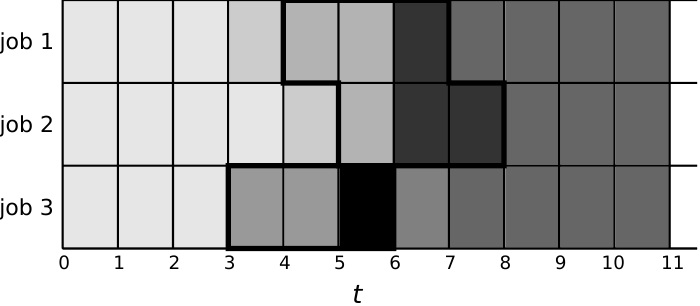
Figure 3. A larger number of sets generated compared to those in Figure 2. Two of the original sets (indicated by bold borders) are split further into the dark grey and black